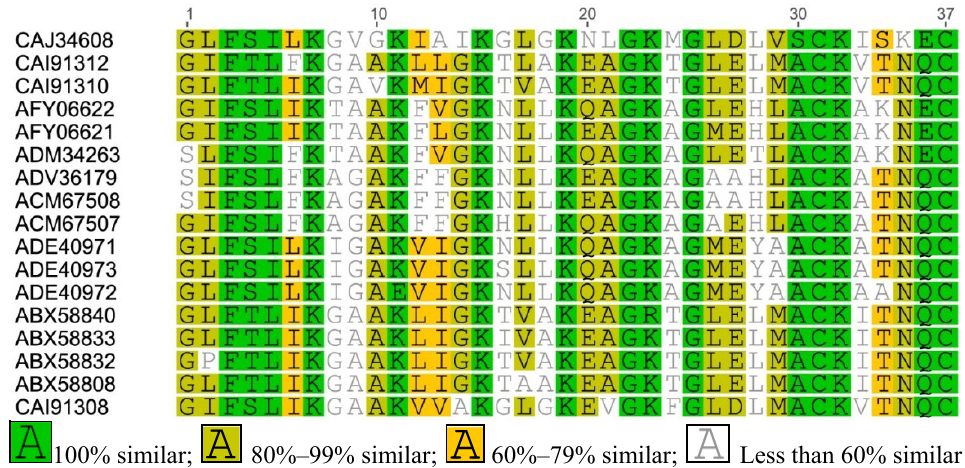
Figure A3. Multiple sequence alignment of Esculetin-1 from Asian frogs.